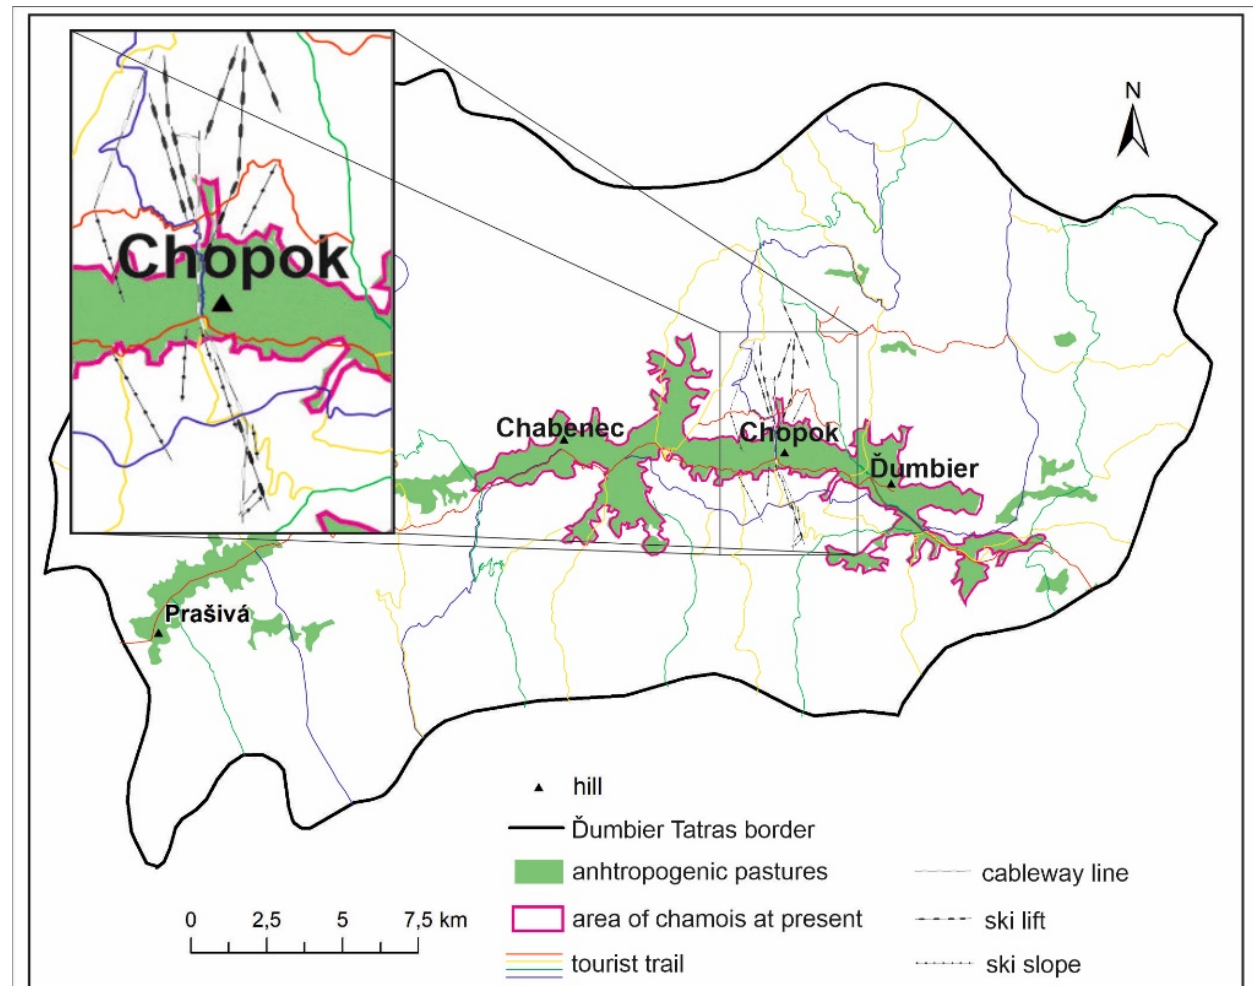
Figure 16. Area of chamois colonization in the ˇDumbier Tatras in relation to recreational infrastructure and superstructure (Source: authors’ research, National Atlas of Slovak Republic,